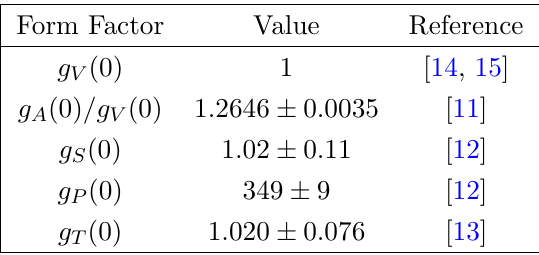
Table 3. Hadronic form factors considered in this